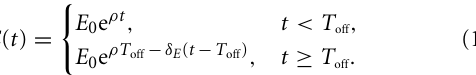
FIGURE 1 | Schematic cartoon of the kinetics of virus-specific CD8 T cell (A) and antibody-secreting cell (B) responses. CD8 T cell response is broken down into the expansion phase, peak, and contraction phase. During the expansion phase, CD8 T cells experience massive growth and reach a peak value at t = T off . Once this point is reached, CD8 T cell numbers begin to decline at a rate δ E . Antibody-secreting cells (ASCs)